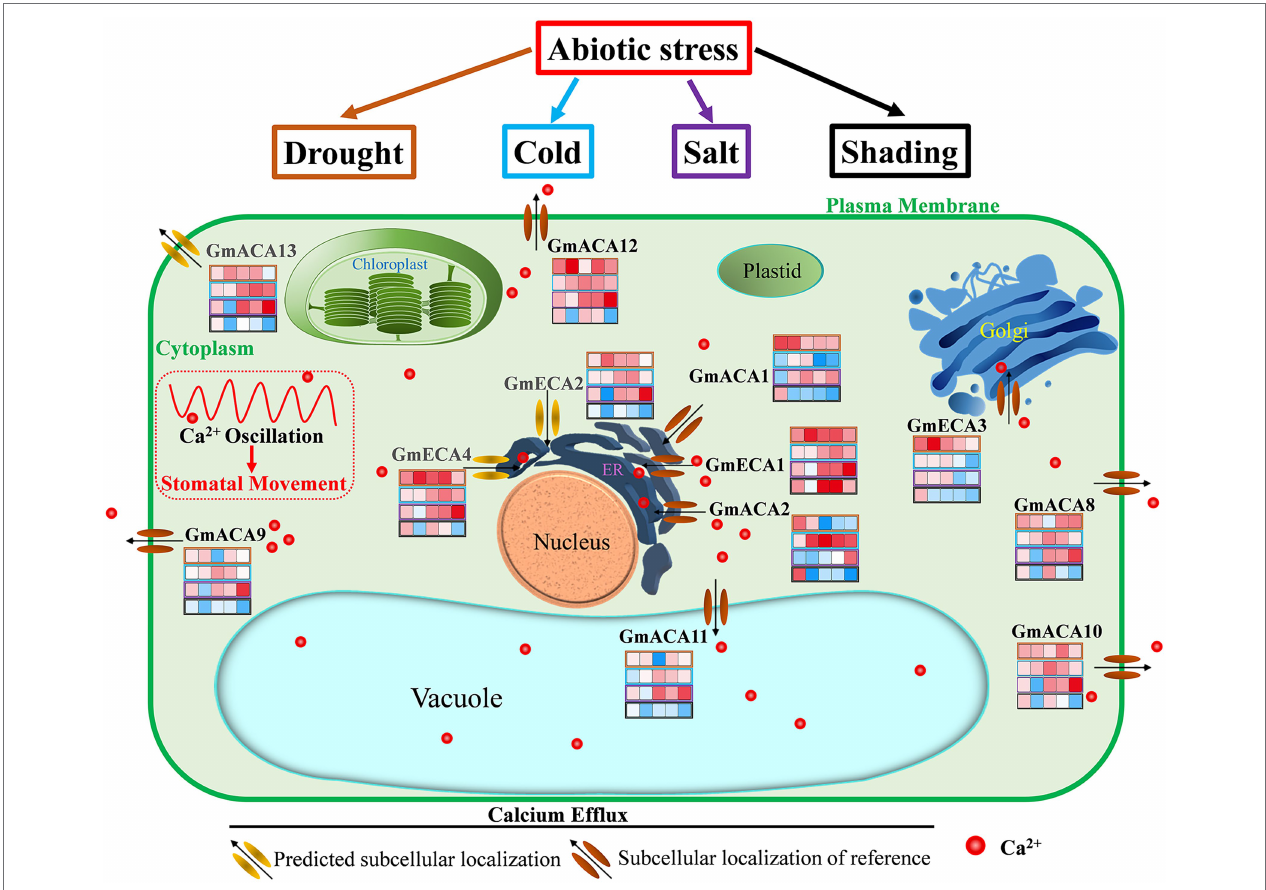
FIGURE 8 | Overview of the regulation of calcium efflux by P 2 -type Ca 2+ pump (GmACAs and GmECAs) in vegetable soybean cells. By referring to the identified transport system of the Ca 2+ pump in Arabidopsis, the schematic representation of the P 2 -type Ca 2+ pump transport system in soybean was summarized. Grey colors of gene names represent predicted subcellular localizations. The heat map represents the expression level of each gene at 1, 6, 12, 24, and 48 h after drought, cold, salt, and shading stress (refer to Figure 6 ). See the text and Table 1 for discussion and